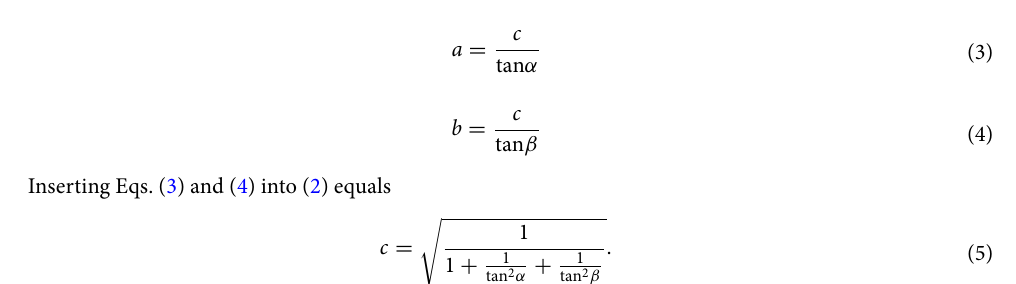
lever at the points of action, which are labeled with g 1 , g 2 , and g 3 , respectively. The distance between the prism’s